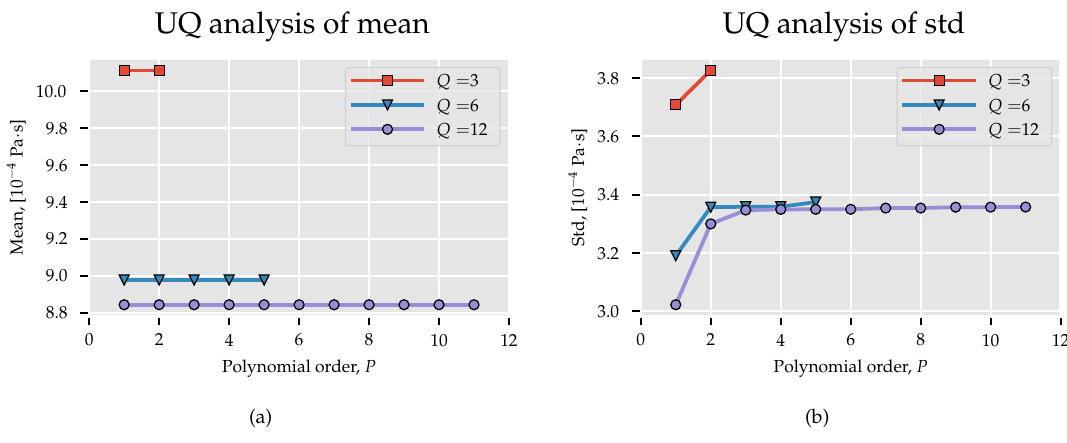
Figure 3. Statistics derived from surrogate MD model. ( a ) Expected value; ( b ) Standard deviation. UQ: uncertainty quantification.